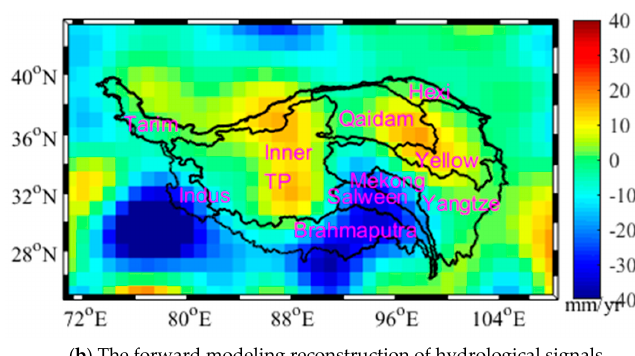
Figure 3. Average annual rates (mm/yr) of the equivalent water thickness between August 2002 and December 2016 derived from ( a ) the GRACE monthly solutions and ( b ) the forward modeling reconstruction of hydrological signals.